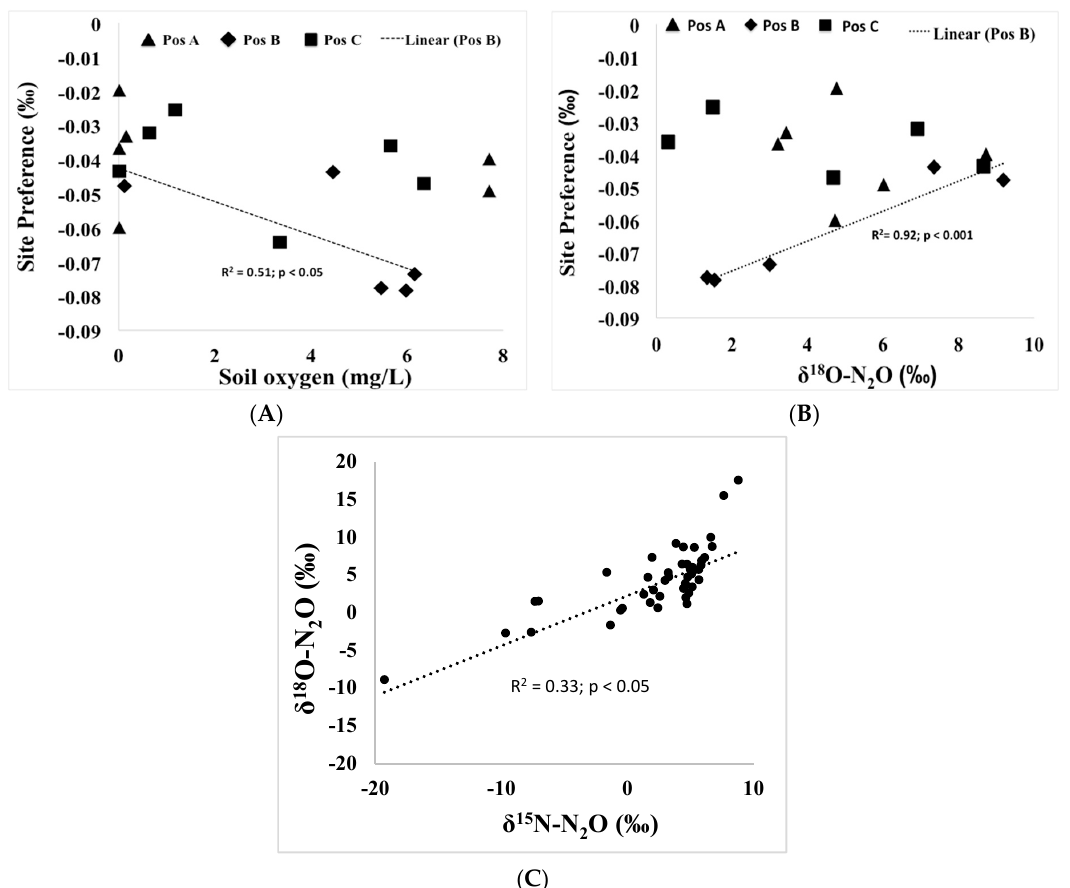
Figure 6. ( A ) Variation of site preference in gas samples in relationship with soil oxygen concentration. Position (Pos) A has anoxic conditions, Positions B and C are suboxic and oxic, respectively. ( B ) N 2 O SP (site preference) vs. δ 18 O relationship for all measurements. ( C ) N 2 O isotopic signatures showing variation of δ 18 O vs. δ 15 N.